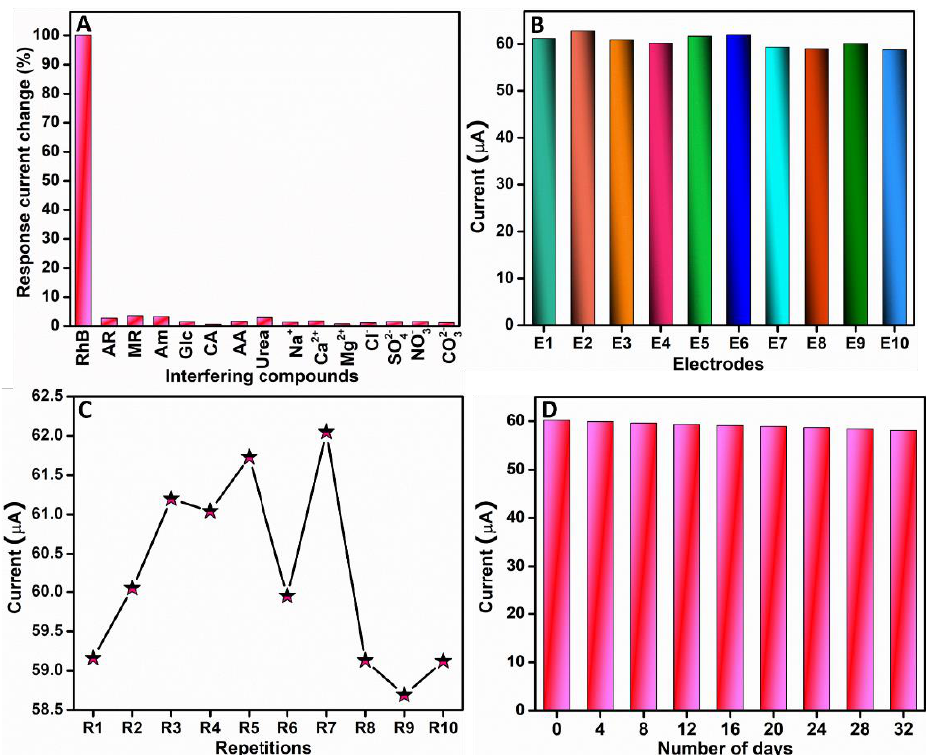
Figure 8. Analysis of ( A ) selectivity, ( B ) reproducibility, ( C ) repeatability, and ( D ) stability of pro- posed RhB sensor. RhB